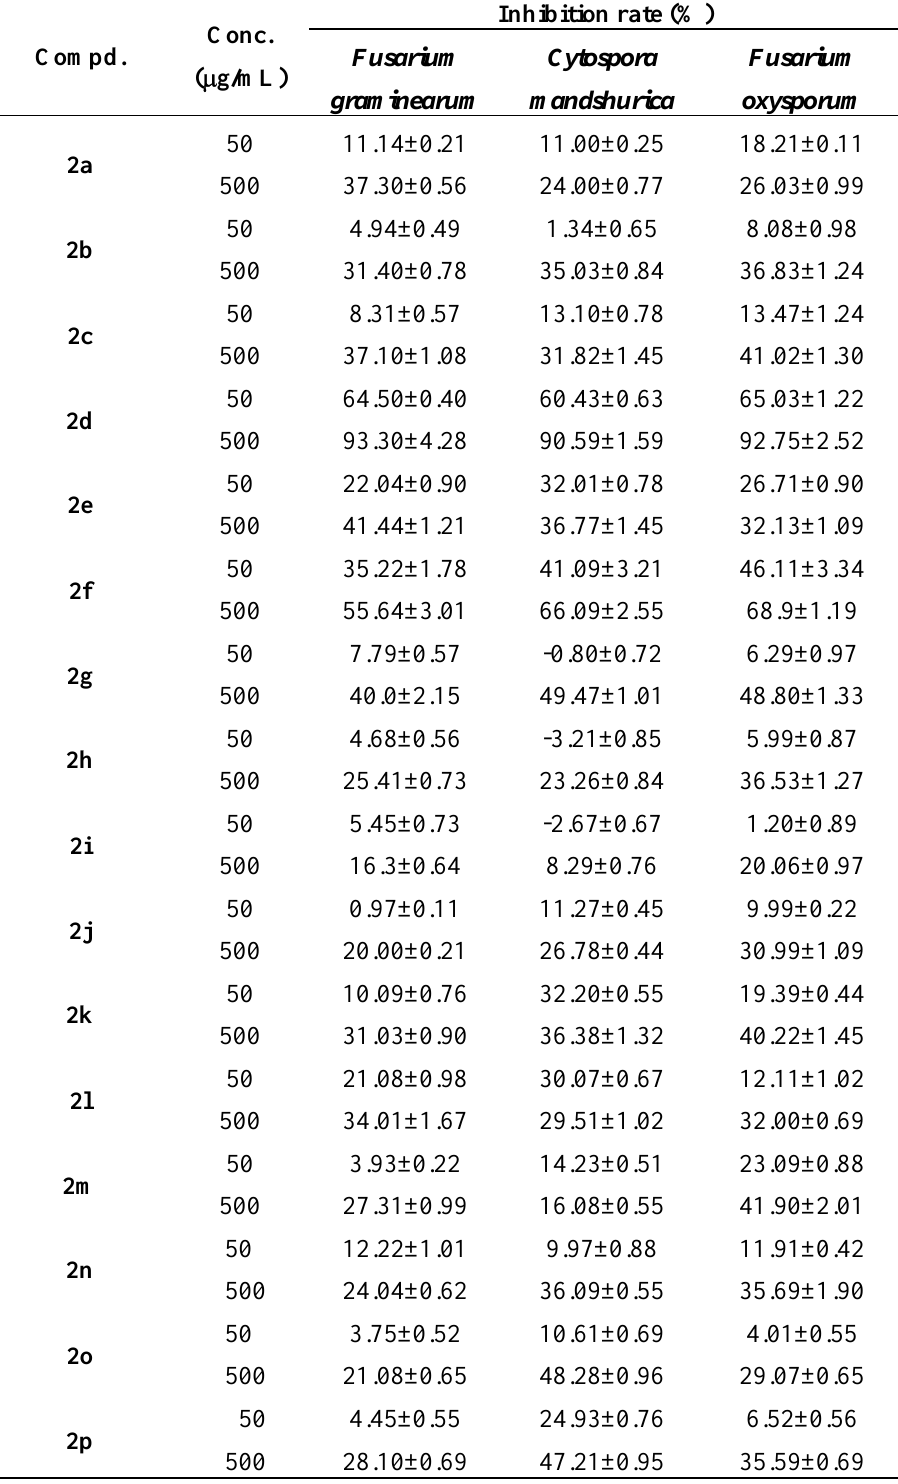
Table 2, the new compounds 2d and 2t exhibited promising antifungal activity, inhibiting growth of F. graminearum at 64.5 and 49.7 %, C. mandshurica at 60.4 and 51.3 % and F. oxysporum at 65.0 and 41.1 %, respectively, which is a little lower than that of hymexazole (73.2 % against F. graminearum , 58.9 % against C. mandshurica, and 65.5 % against F. oxysporum at 50 µg/mL). Marked loss of activity was observed with other compounds such as 2a-2c and 2e-2s . Table 2. Inhibition effects of the title compounds on